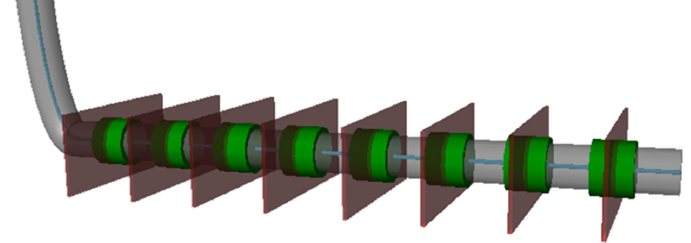
Figure 7. Numerical reservoir model.